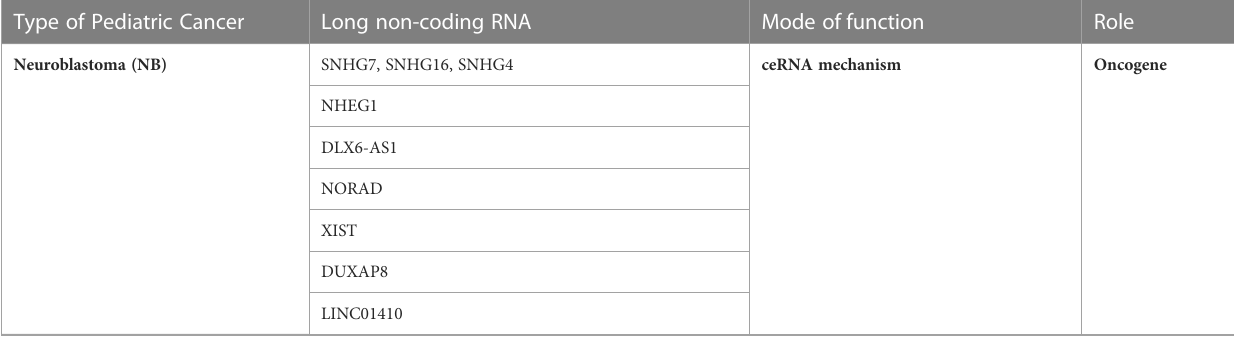
TABLE 1 Features different types of lncRNAs and their roles in pediatric cancer. Type of Pediatric Cancer Long non-coding